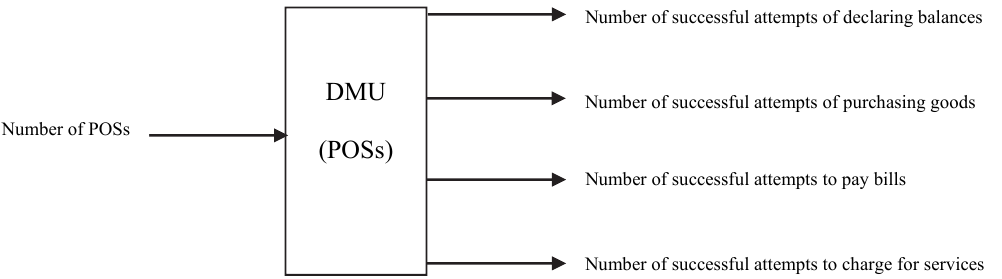
Number of successful attempts to charge for